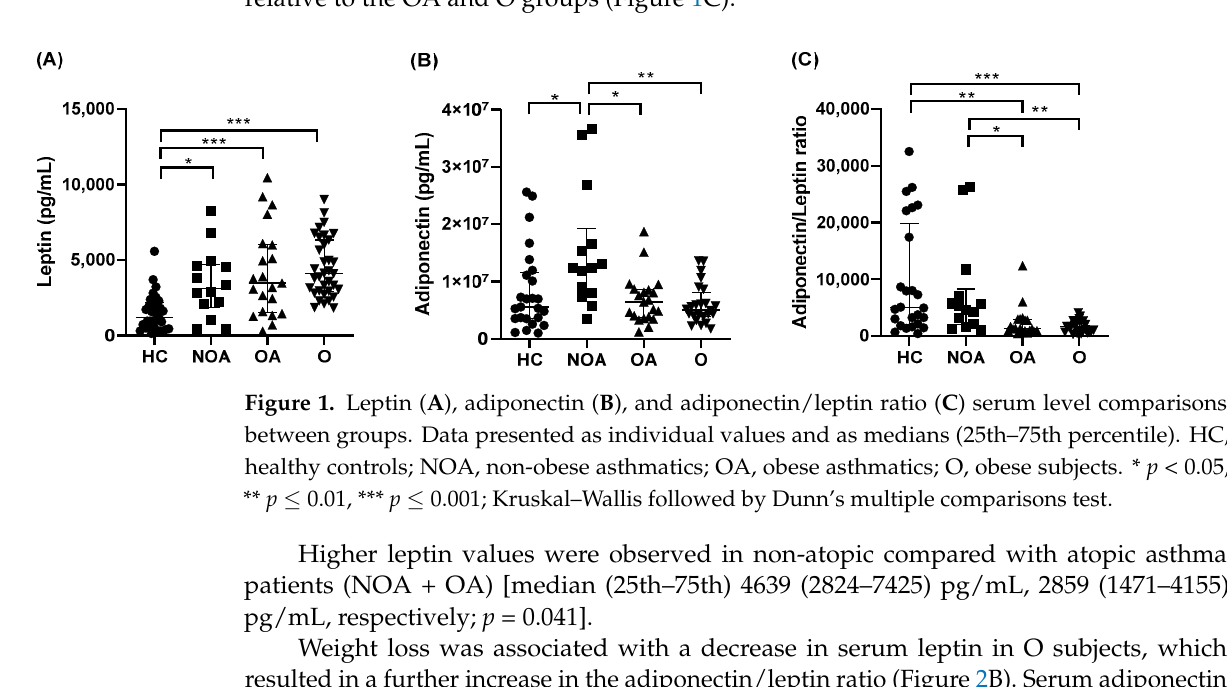
statistical significance was reached (Figure 2A).